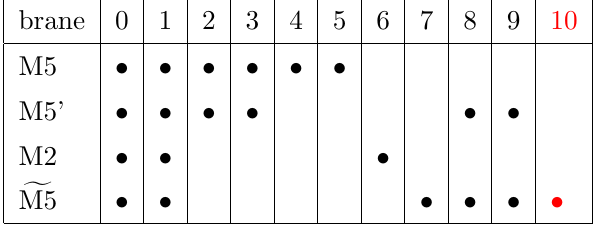
Table 2 . M-brane